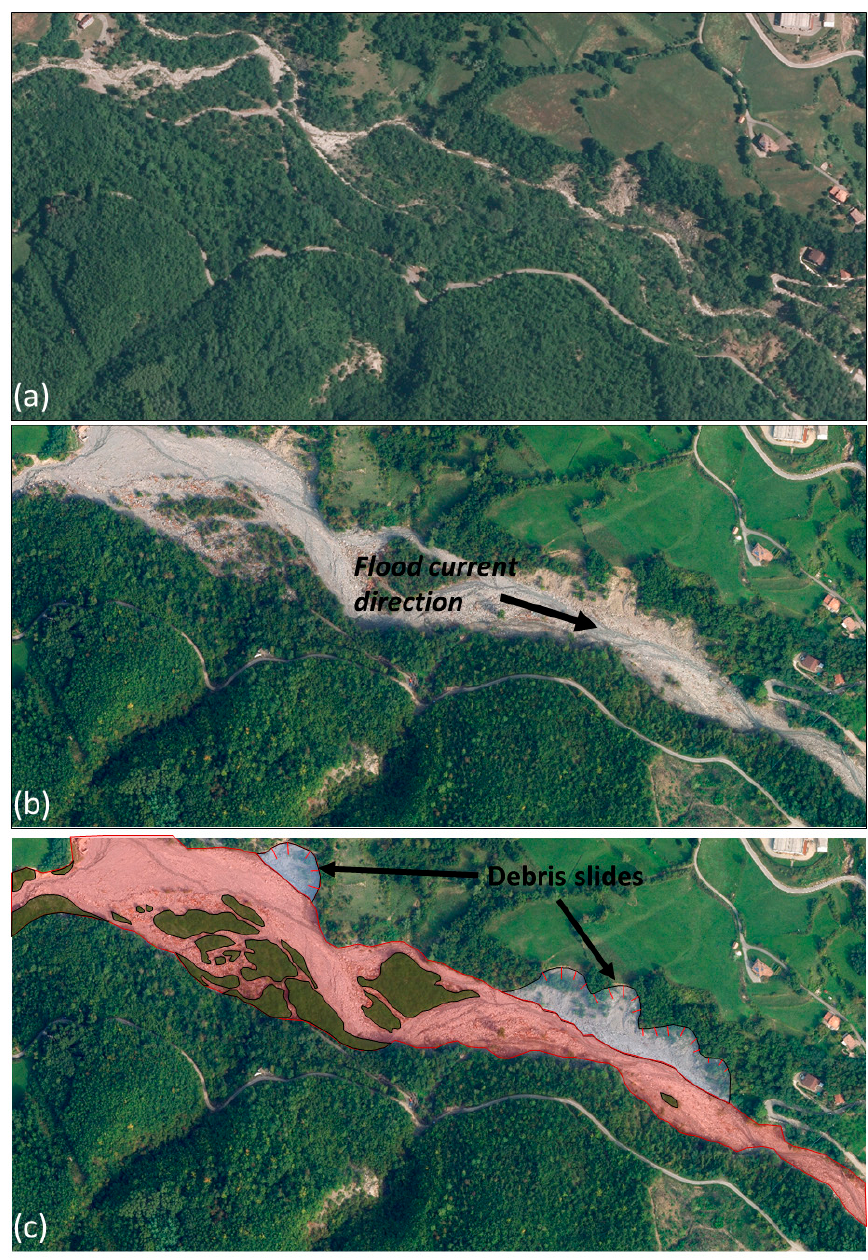
Figure 13. Satellite imagery of the Nure River before ( a ) and after ( b ) the high-discharge flood in September 2015. ( c ) Example of removal of the ligneous vegetation cover in the streambed of the Nure River, eroded areas are in red.